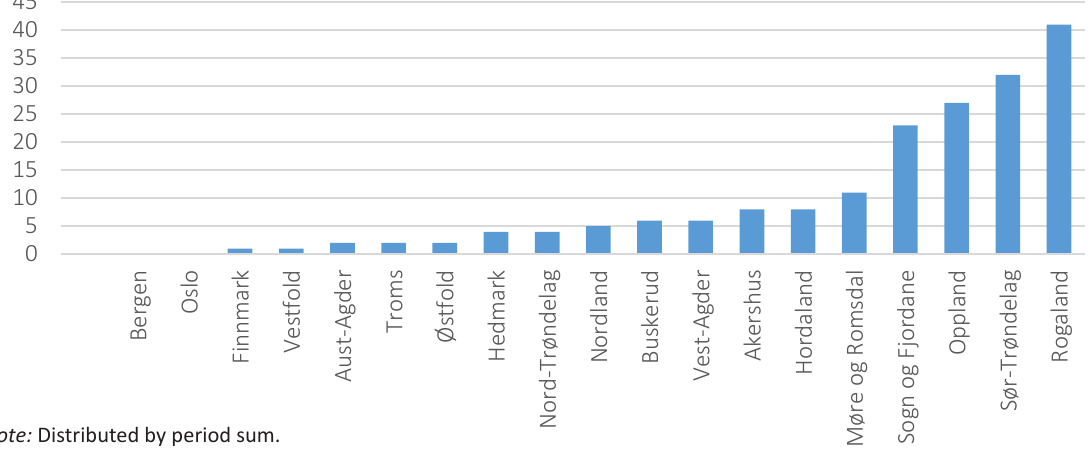
Figure 3. Distribution of Haugean parliamentarians by counties